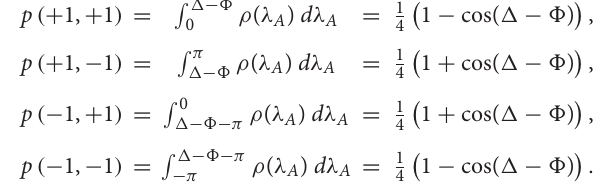
FIGURE 4 | Plot of the transformation law λ line), compared to the corresponding linear transformation (dotted